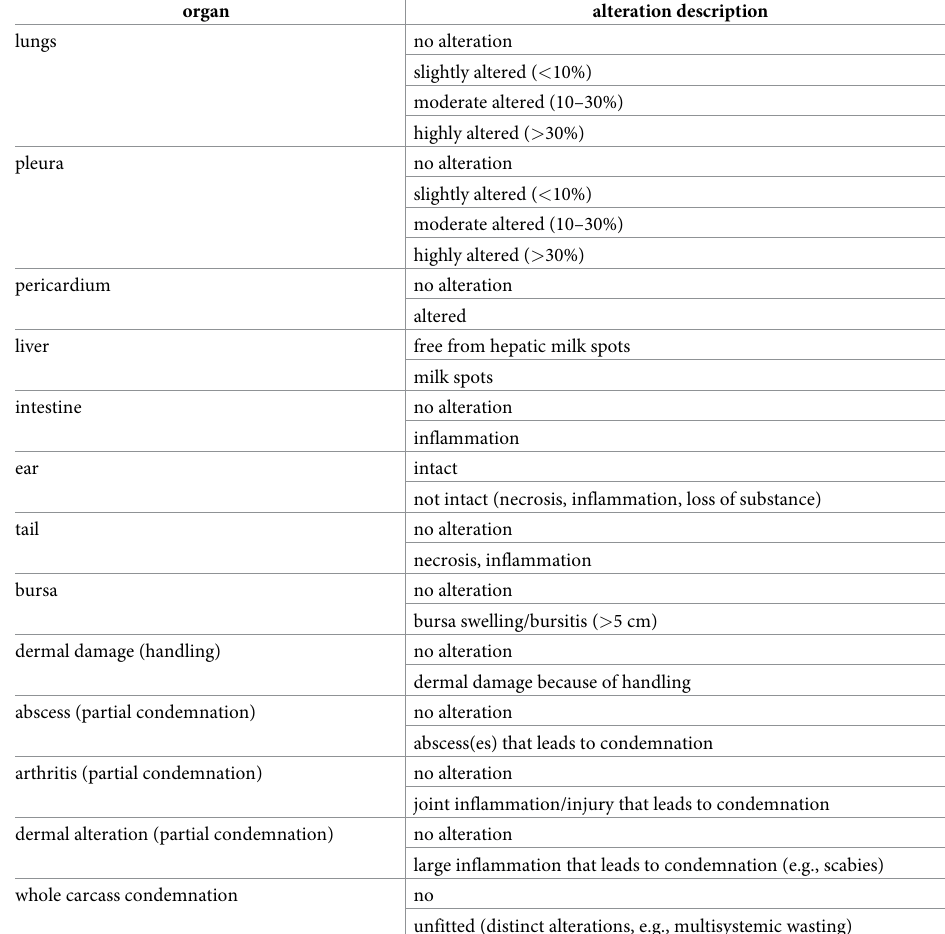
Table 1. QS’s coding scheme for meat inspection at slaughter for pigs.